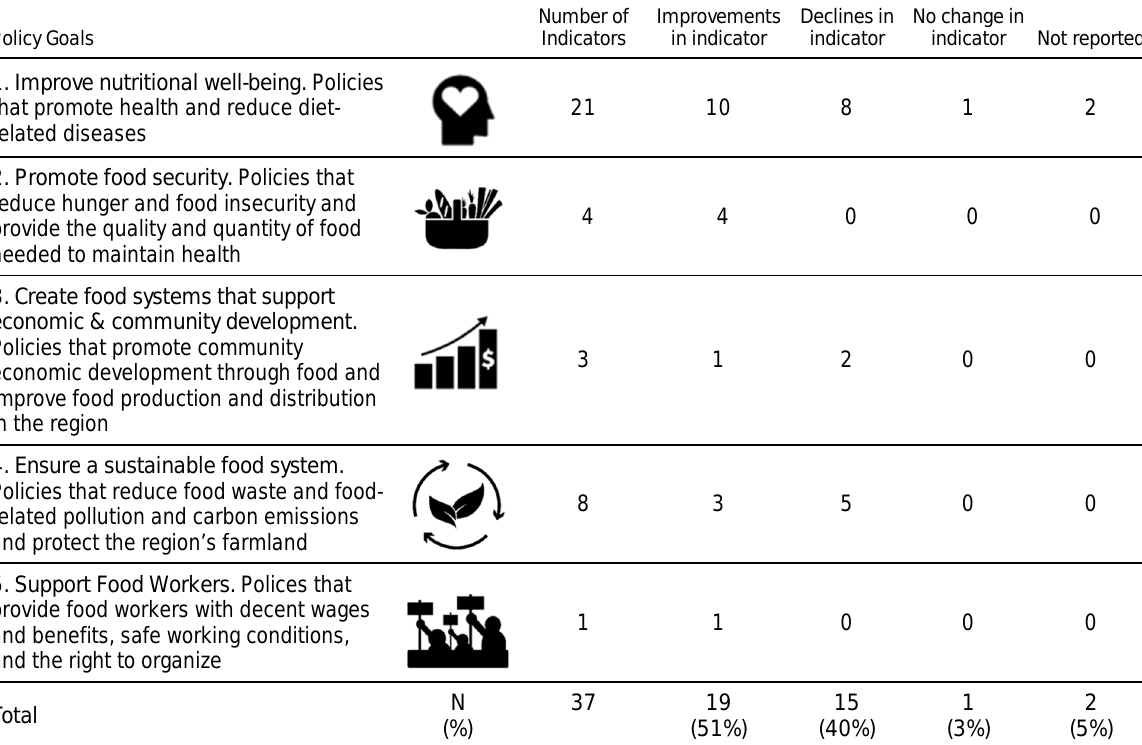
Table 1. Distribution of Food Metrics Indicators by Goals and Direction of Change Policy